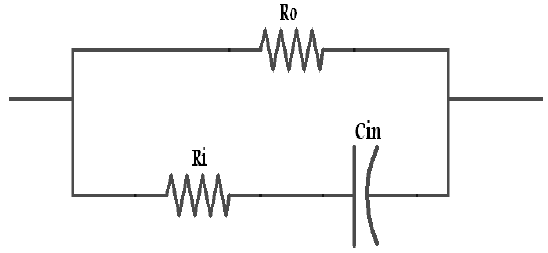
Fig. 1: Equivalent Electrical circuit model of the human body